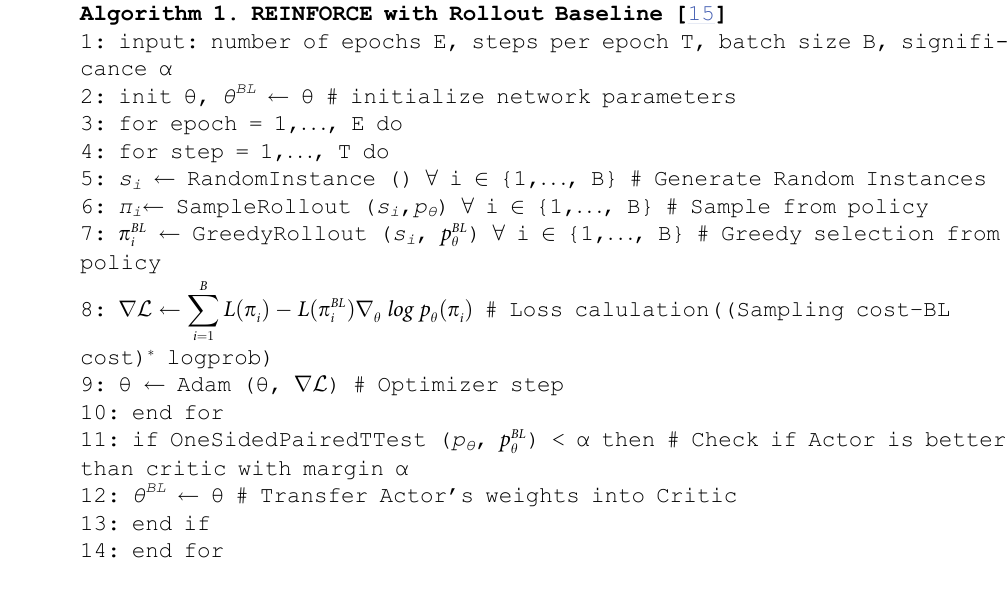
Algorithm 1. REINFORCE with Rollout Baseline [ 15